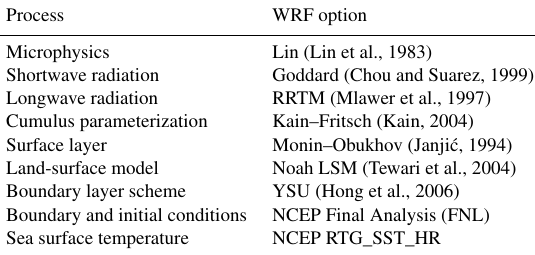
Table 1. WRF model